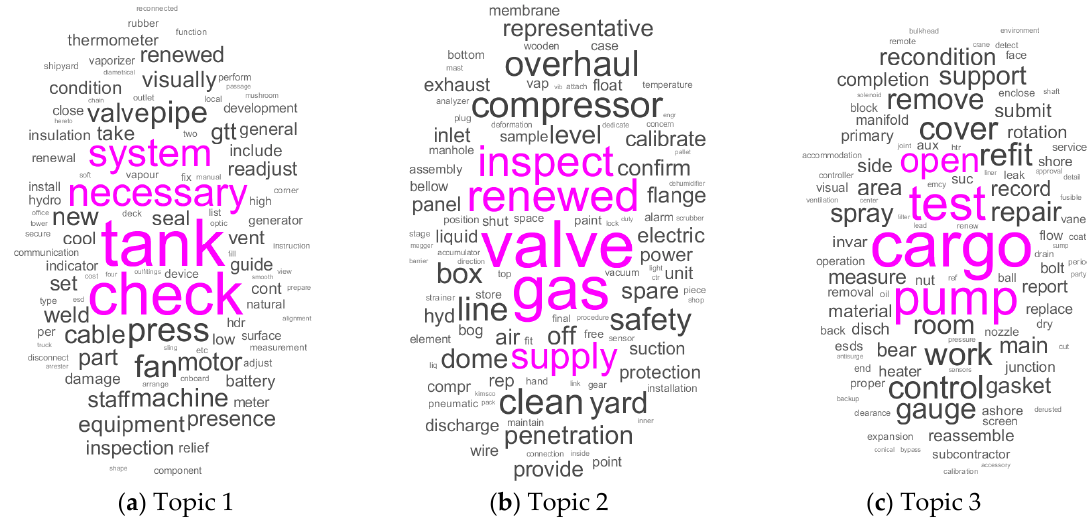
Figure 8. Topic model of LNGCs aged more than 20 years. ( a ) Topic 1: tank-check-system; ( b ) Topic 2: valve-gas-renewed; ( c ) Topic 3: